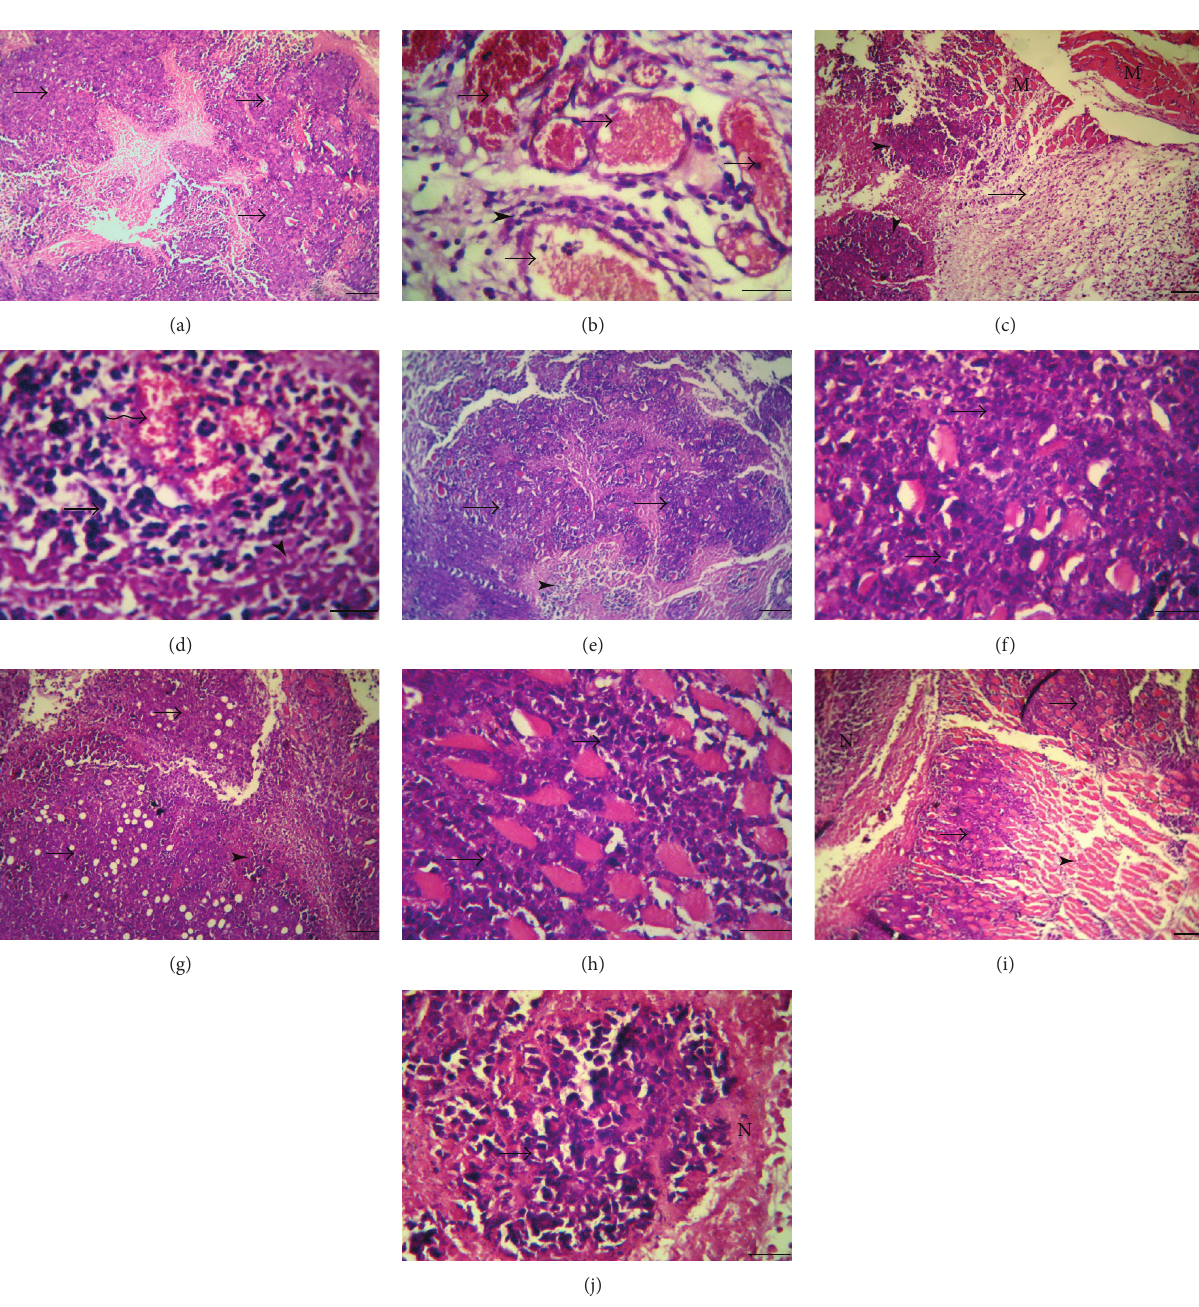
Figure 3: Histopathological examination of Ehrlich ascites carcinoma (EAC) solid tumor. Representative sections were obtained from (a) untreated EAC-bearing mice (arrows: infiltration of subcutaneous tissue with tumor cells), (b) untreated EAC-bearing mice (arrows: newly formed blood capillaries; arrowheads: leukocyte infiltration), (c) EAC tumor-bearing mice treated with 5-fluorouracil 20 mg/kg (arrowheads: extensive necrosis; arrow: fibrosis; M: skeletal muscles), (d) EAC tumor-bearing mice treated with 5-fluorouracil 20 mg/kg (irregular arrow: destructed blood vessels and hemorrhage), (e) EAC tumor-bearing mice treated with spirulina 200 mg/kg (arrows: extensive infiltration of the subcutaneous tissue with tumor cells), (f) EAC tumor-bearing mice treated with spirulina 200 mg/kg (arrows: tumor cells with cellular anaplasia and anisocytosis), (g) EAC tumor-bearing mice treated with spirulina 800 mg/kg (arrows: moderate infiltration of the tumor cells; arrowhead: numerous leukocyte infiltration), (h) EAC tumor-bearing mice treated with spirulina 800 mg/kg (arrows: huge numbers of tumor cells infiltrating the skeletal muscles), (i) EAC tumor-bearing mice treated with 5-fluorouracil 20 mg/kg plus spirulina 200 mg/kg (arrows: less infiltration with tumor cells; N: extensive necrosis and fibrosis), and (j) EAC tumor-bearing mice treated with 5-fluorouracil 20 mg/kg plus spirulina 200 mg/kg (arrows: islets of viable tumor cells; N: extensive necrosis). Sections were stained with HE dyes (scale bar = 50 𝜇